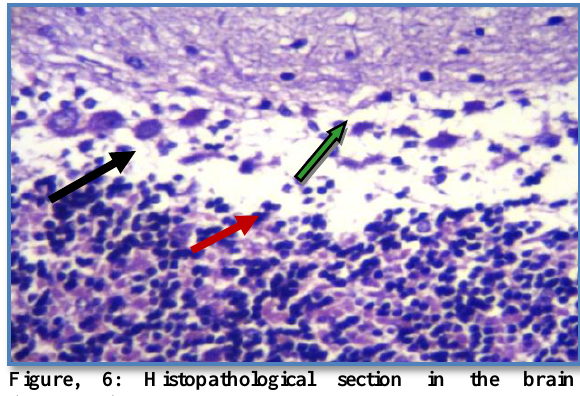
Figure, 6: Histopathological section in the brain (cerebrum) of mice injected I/P with 0.1ml of suspension of digested organs at day 28 showing edema between molecular and granular layer ( ) with degeneration of purkinje cells ( ) in addition to complete dissolution of the other ( ) H and E